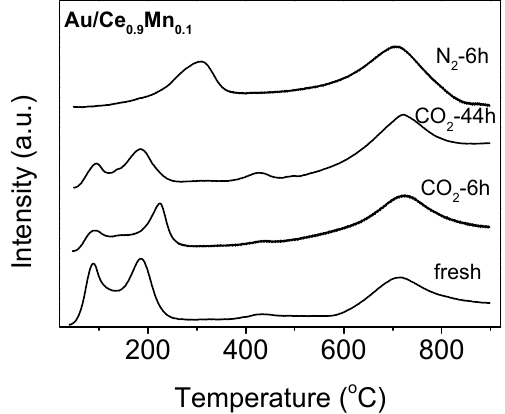
Figure 7. TPR profiles of fresh and spent Au/Ce 0.9 Mn 0.1 catalysts.